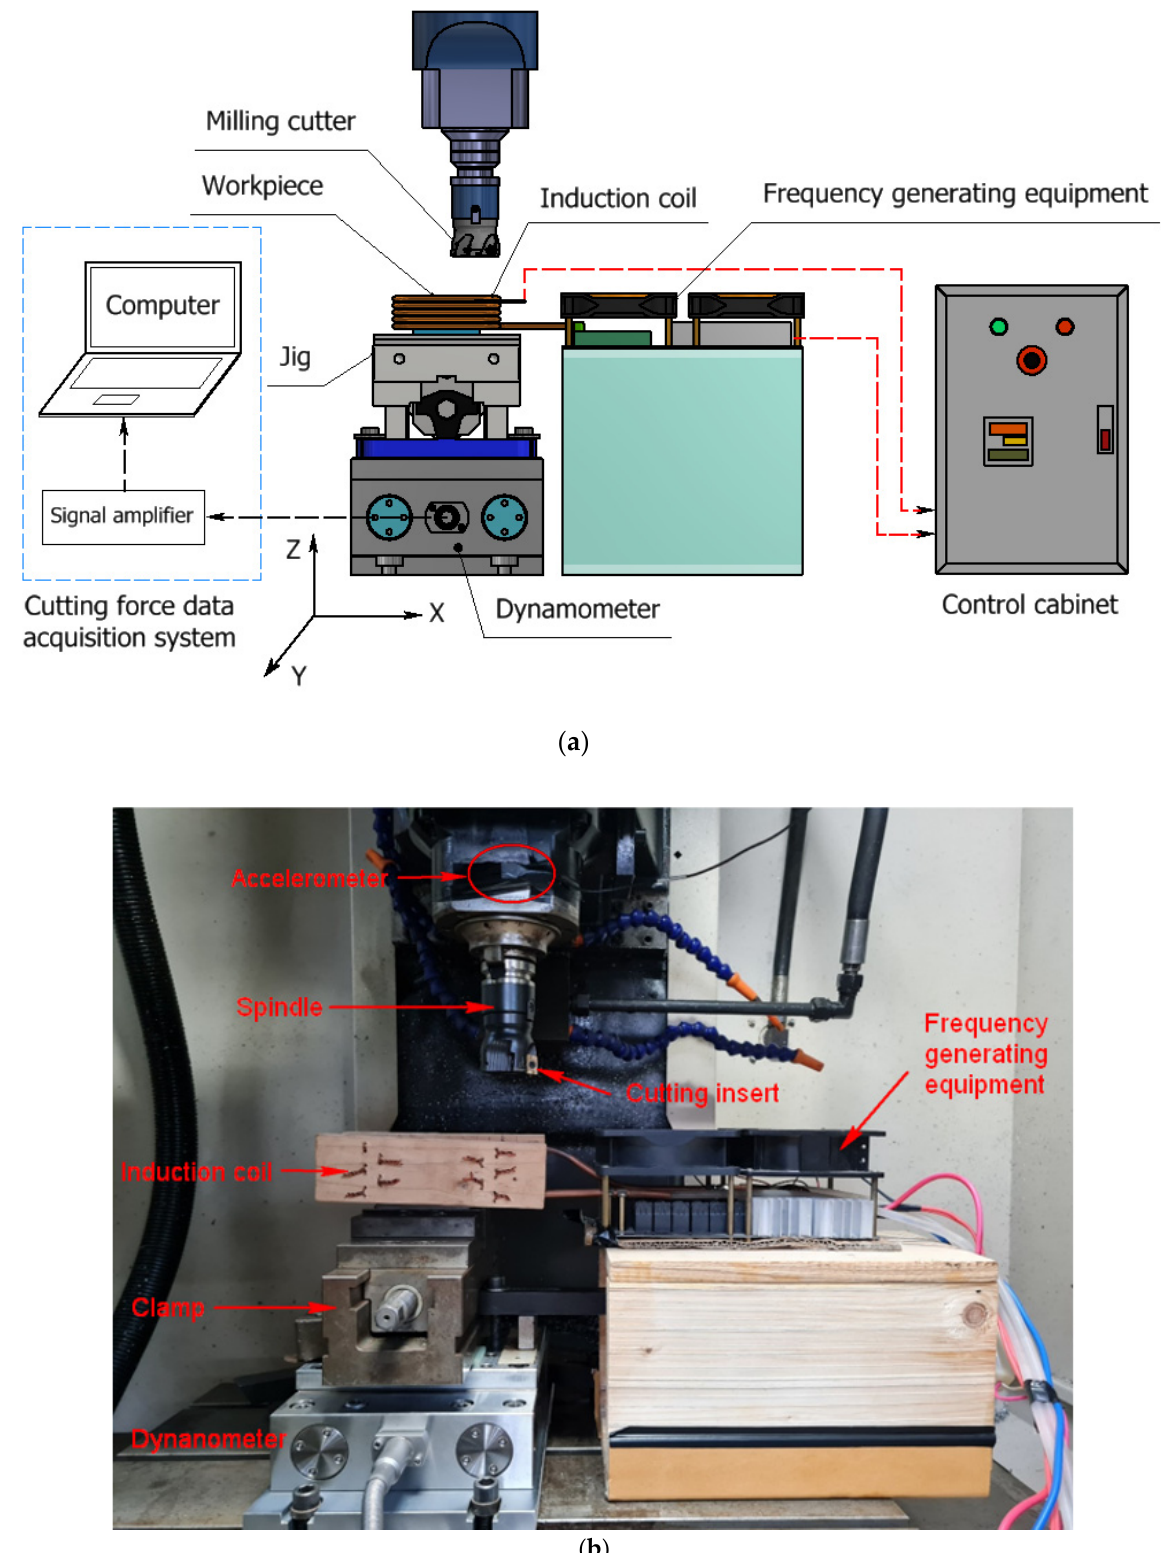
Figure 1. Schematic of Experimental System. Schematic diagram ( a ) and experiment photograph in working zone ( b ).